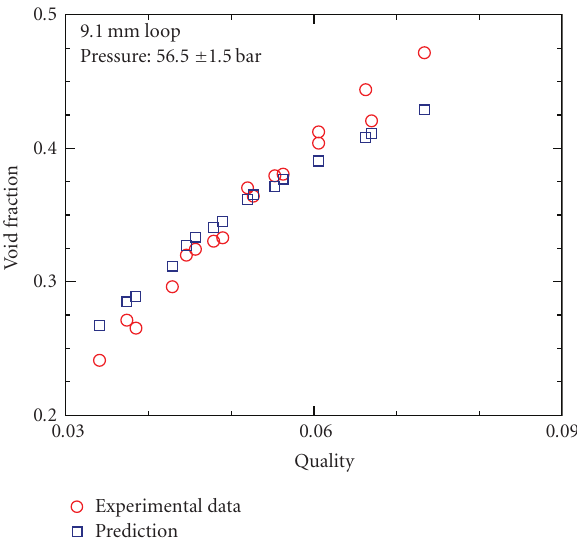
Figure 8: Comparison of measured void fraction with that predicted using Ishii model [31]